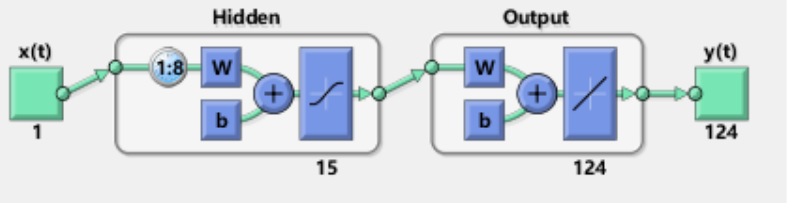
Figure A1. The structure of the BP neural network index forecast model of the elderly care service resources demand system.